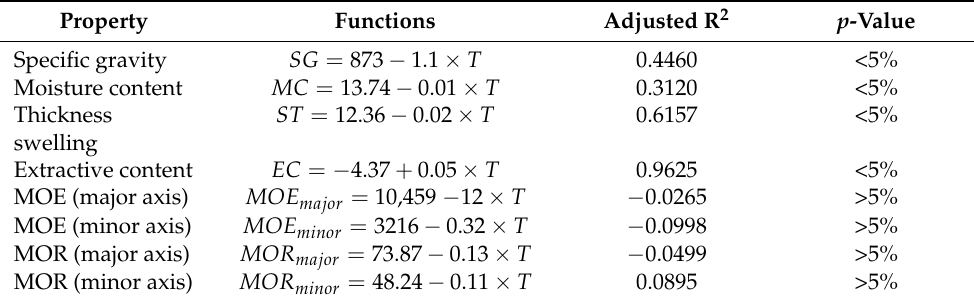
Table 1. Simple linear regression correlating plywood properties with heat treatment